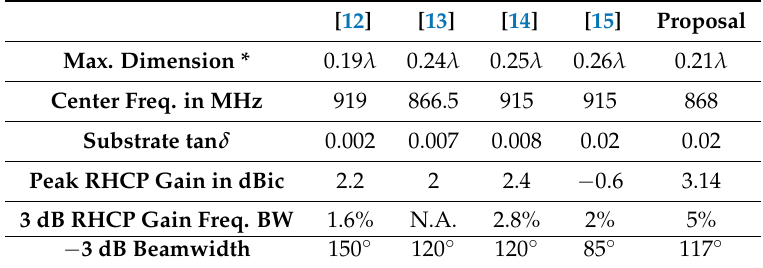
Table 2. Performance comparison with the